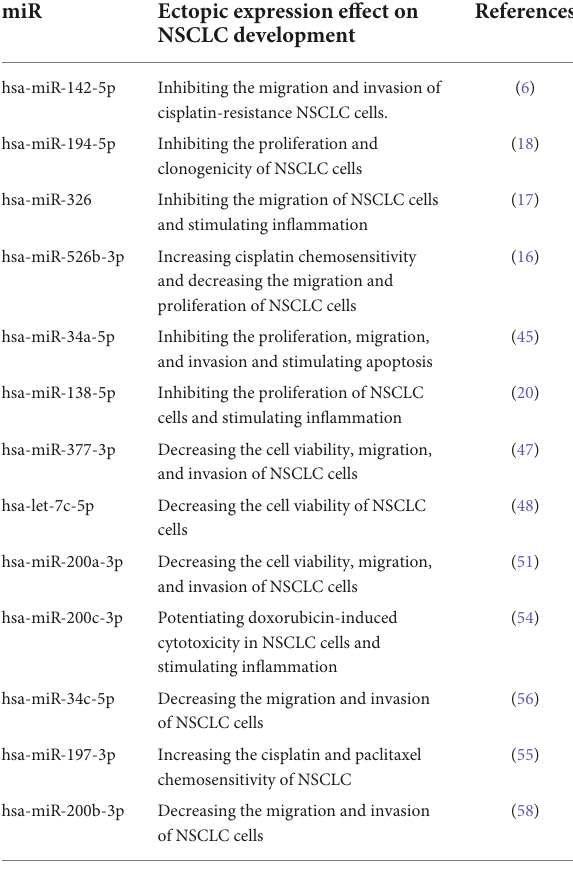
TABLE 3 The tumor-suppressive PD-L1-inhibiting miRs in NSCLC. miR Ectopic expression effect on NSCLC